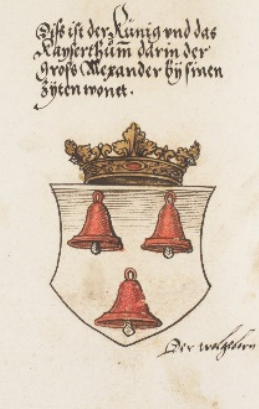
( b ) Figure 14. ( a ) CoA of the marquise of Oliveto, Naples. ( b ) CoA of the dukes of Campora, Naples. Since both views on the origins of the Macedonian and Bulgarian land coats of arms are not conclusive, there is a possibility of a third: two different sources with relatively similar blazons resulting in simplification and inverse coloring of both of the coats of arms. This would mean that it is quite possible that the Macedonian coat of arms was taken over by Capaccio, who took it from another older source. First of all, the coats of